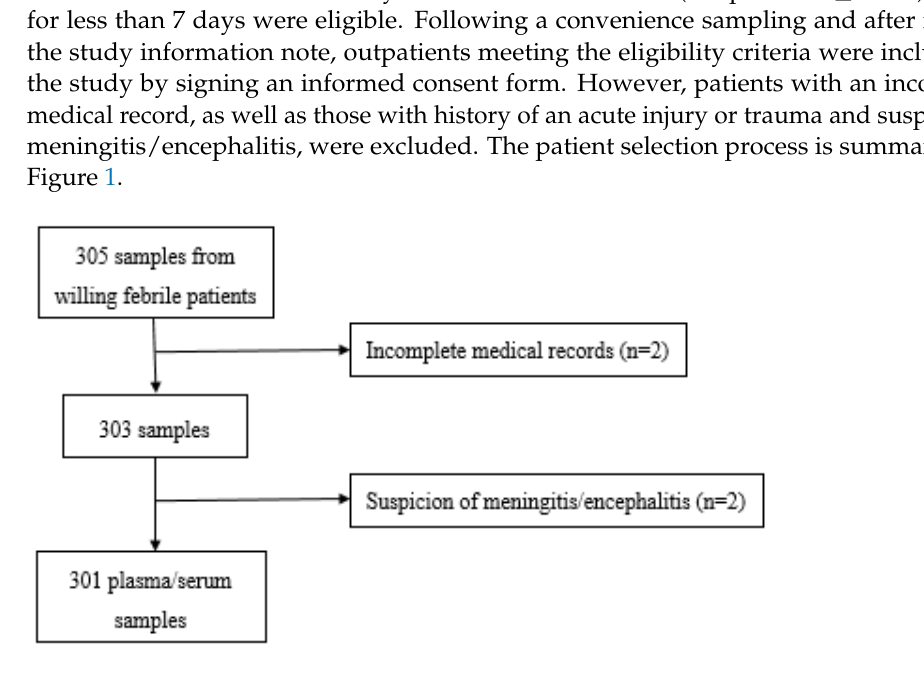
Figure 1. Flowchart of the study patient selection.